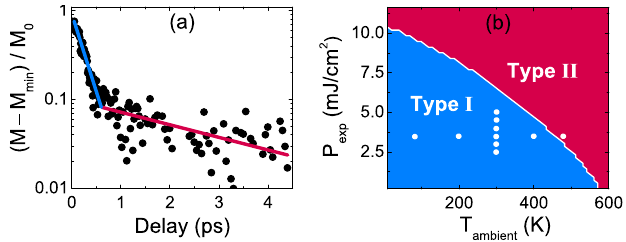
FIG. 4. Two-step dynamics of nickel. (a) Experimental verifi- cation of two-step dynamics in nickel at an ambient temperature of 480 K. (The data are taken from Fig. 3.) M min denotes the minimum magnetization, and the lines serve as a guide to the eye. For the fast step, we obtain a time constant of approximately 0 : 2 ps , whereas the slow step occurs within approximately 4 ps . (b) Calculated phase diagram for ultrafast demagnetization in nickel. The white dots indicate the operating conditions of the experiments in Figs. 2 and